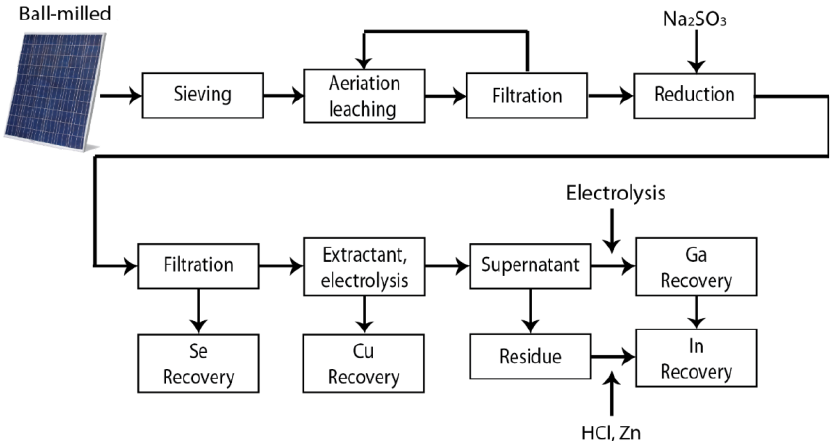
Figure 6. Recycling of CIGS thin-film PV module by acid leaching, extraction, and electrolysis flow chart .